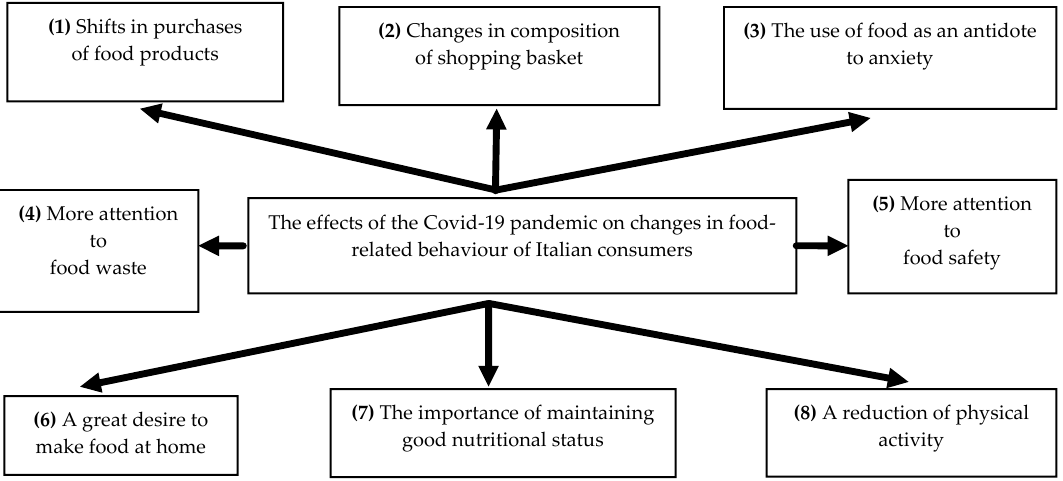
Figure 6. The effects of the COVID-19 pandemic on changes in eating habits and lifestyle.